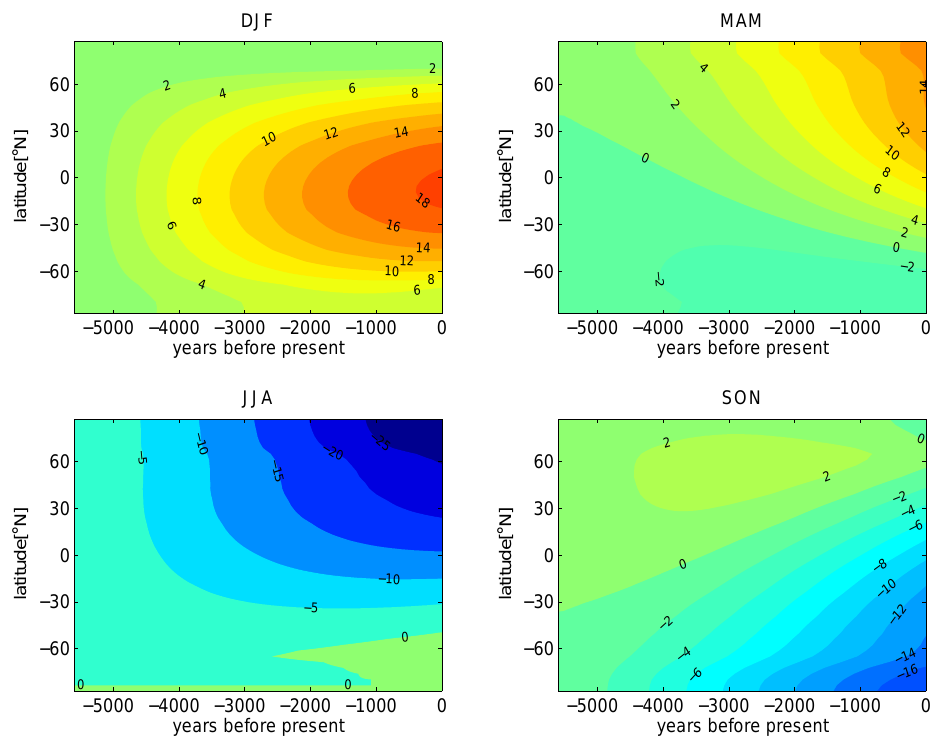
Fig. 4. Changes in seasonal insolation from the mid-Holocene to today in Wm − 2 (winter – DJF, spring – MAM, summer – JJA, autumn – SON, seasons are defined after present-day’s calendar). The reference is 6000yr before present.